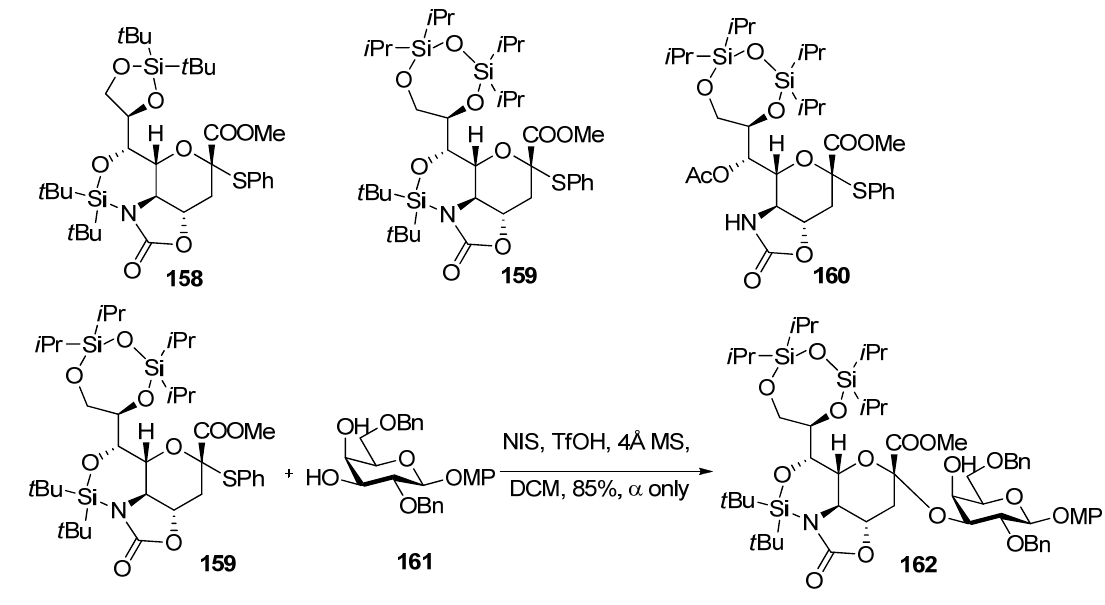
Figure 5. Plausible reaction mechanism of the donor 159